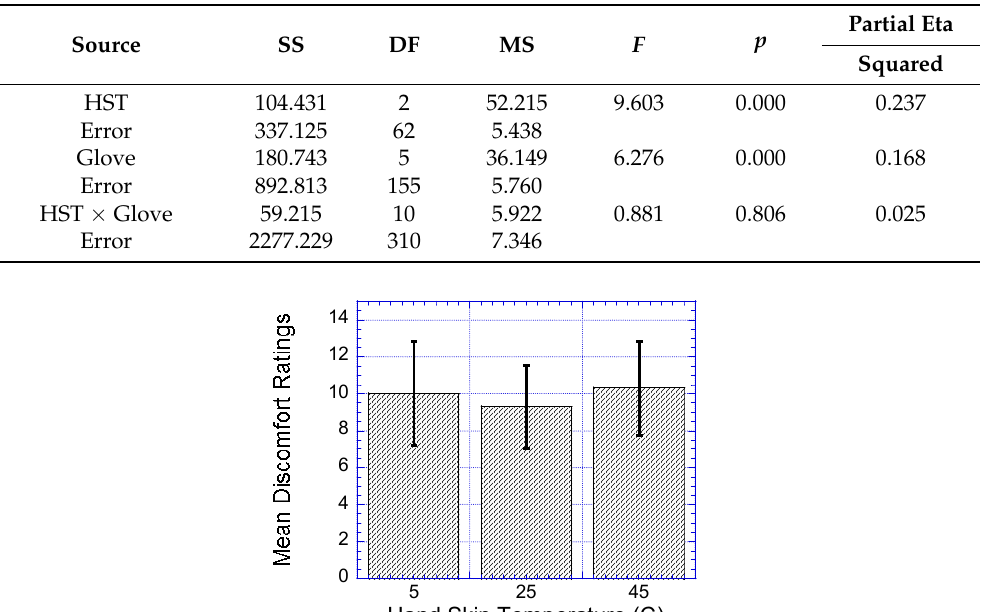
Table 7. Result of the ANOVA for discomfort rating measured at three hand skin temperatures and the six glove conditions (bare-hand and five glove conditions).